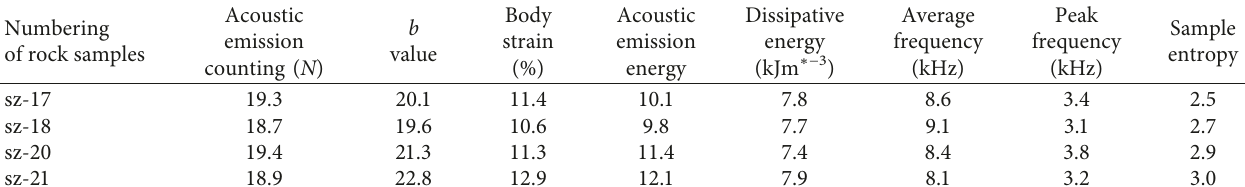
Table 4: Comprehensive index warning